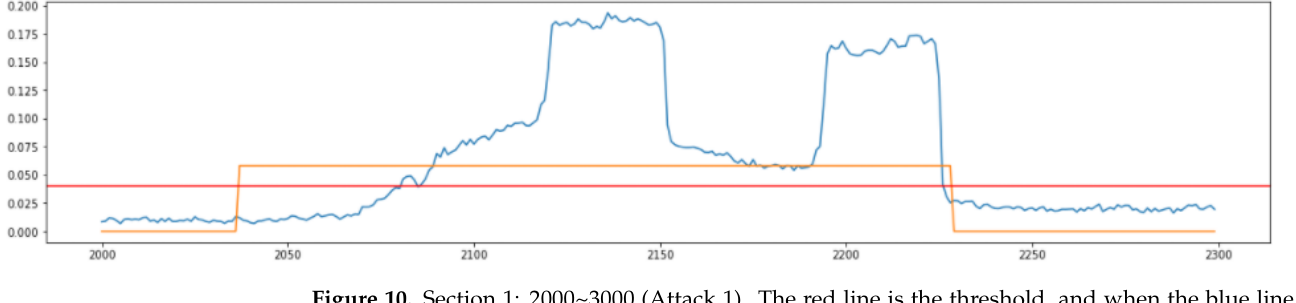
Figure 10. Section 1: 2,000~3,000 (Attack 1). The red line is the threshold, and when the blue line crosses the red line, we predict an attack. The orange line is the actual attack range.